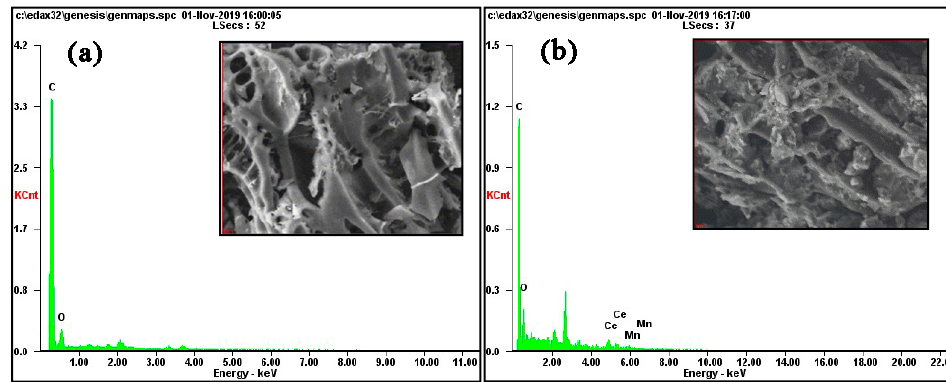
Figure 1. SEM images and corresponding EDS spectra of ( a ) BC and ( b ) MBC.